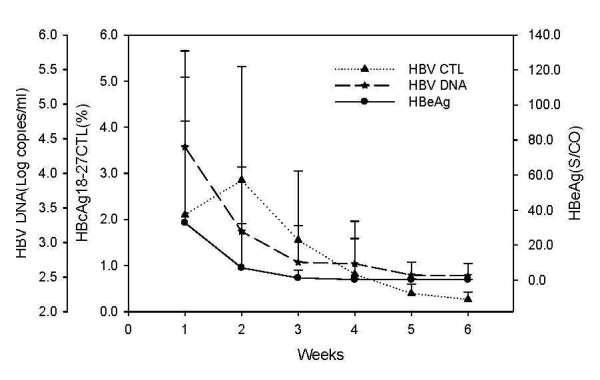
The relationship between the frequency of peripheral blood HBcAg18-27-specific CTLs and HBV clearance in AHB patients. HBV infection in AHB patients was measured by the viral load (HBV DNA amount) and level of HBeAg at weeks after admission to hospital.